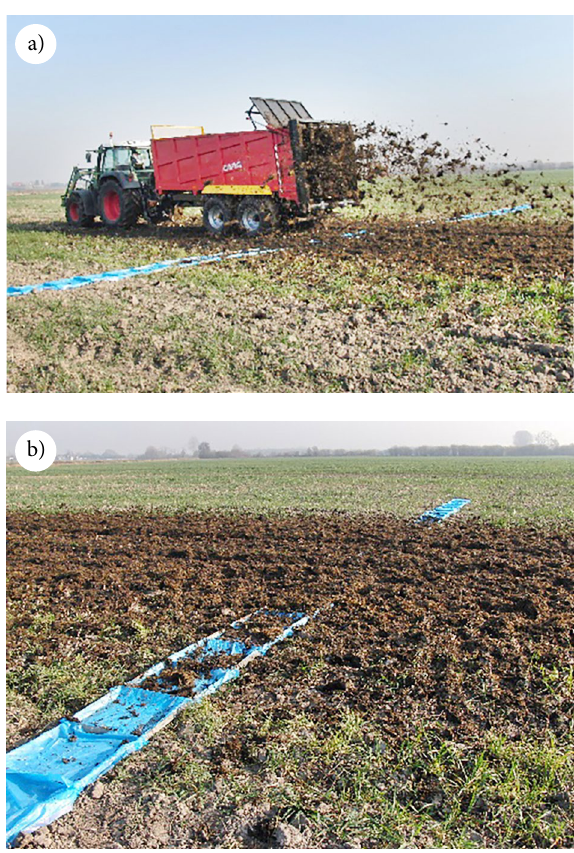
Figure 2. Manure spreader made by the Wielton company with 2 vertical drum spreading adapter when testing the transversal unevenness of manure spreading: a – movement of machinery over the laterally situated boxes for manure; b – distribution of manure in the boxes and on the field Table 5. Percentage share of the compacted field surface during manure spreading operation Farm Fertilizing aggregate: Width of wheel traces Machine working symbol tractor and spreader left and right [m] width